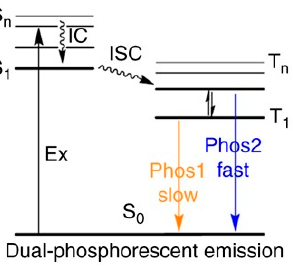
Figure 15. Jablonski diagram for dual phosphorescent emission of 59 – 63 . Adapted with permission from [62]. Copyright 2017, Springer Nature.